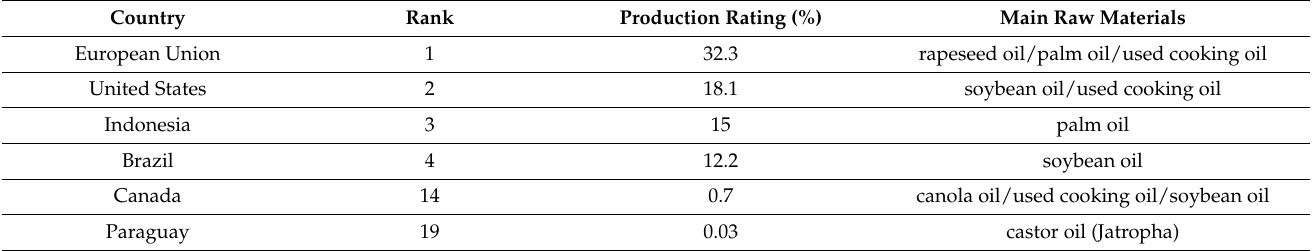
Table 1. Assorted types of primary biodiesel feedstocks for selected countries. Adapted with permission from ref. [21]. 2021,